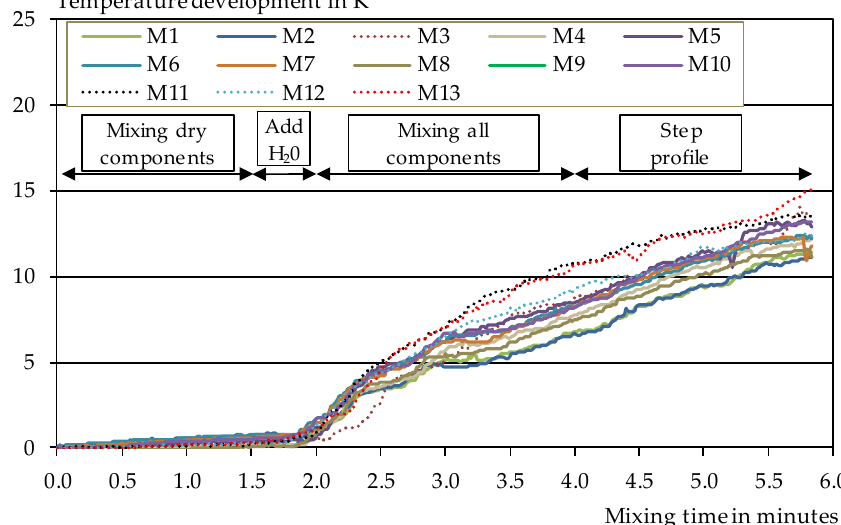
Figure 7. Relative temperature increase from the start of mixing for all mixtures. Non-extractable mixtures are shown in dotted lines.